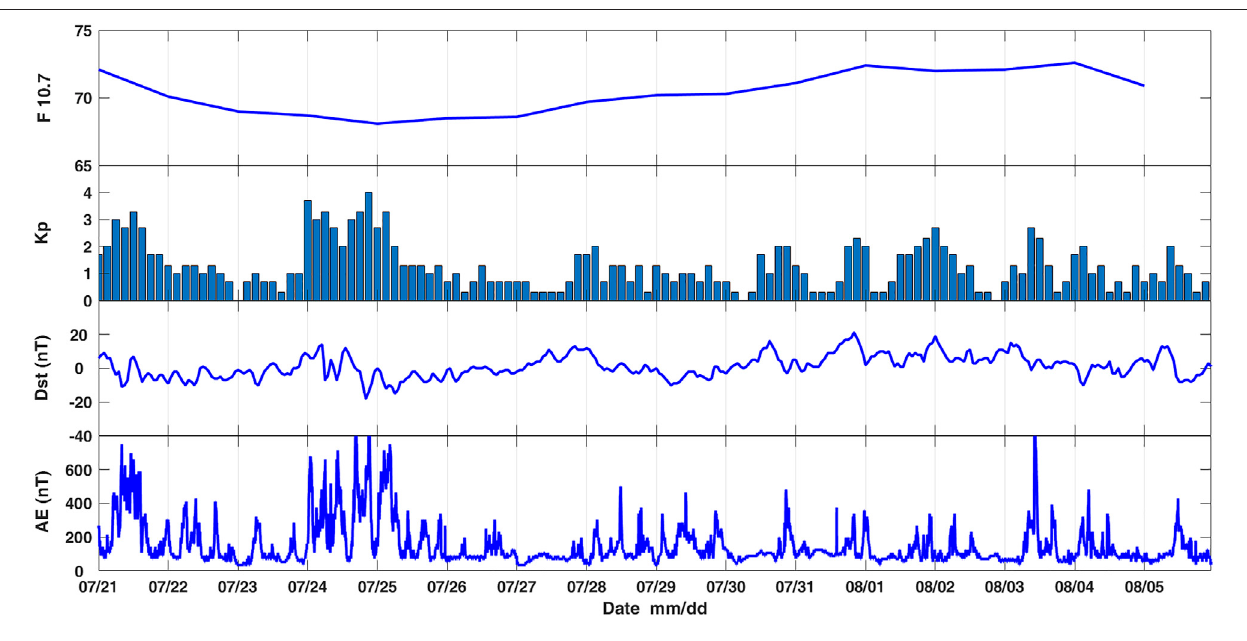
FIGURE 2 | F 10.7 , K p, D st, and AE indices from 21 July to 5 August 2018.